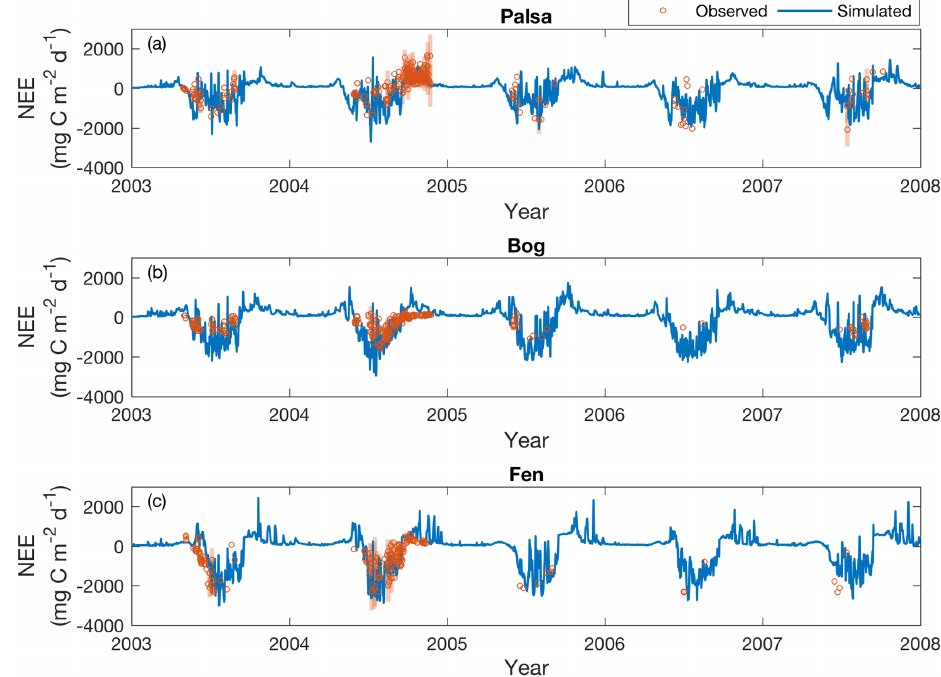
Figure 5. Simulated (solid lines) and measured (open circles) daily CO 2 exchanges (NEE) in the palsa (a) , bog (b) , and fen (c) sites from 2003 to 2007. Shaded bars are the standard deviations of daily NEE measured across subsites under each peatland type. Positive and negative values indicate effluxes from and influxes to the site,